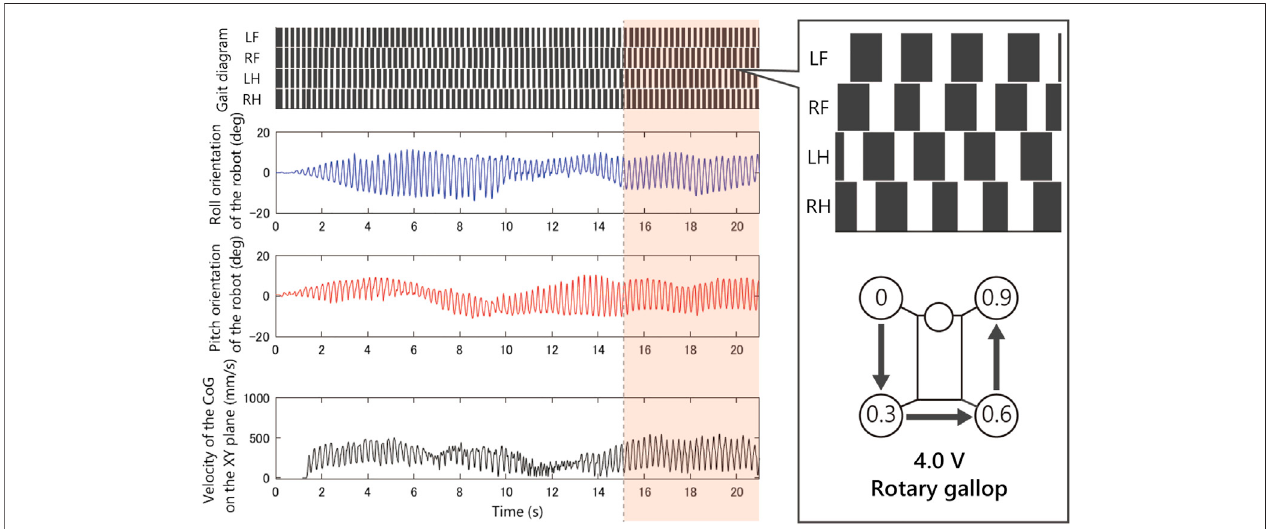
FIGURE11| Experimentalresultwithaninputvoltageof4.0 V.Fromthetop:gaitofthequadrupedrobot,roll,andpitchorientation.Thisrotarygallopgaitemerged from only a few initial values.